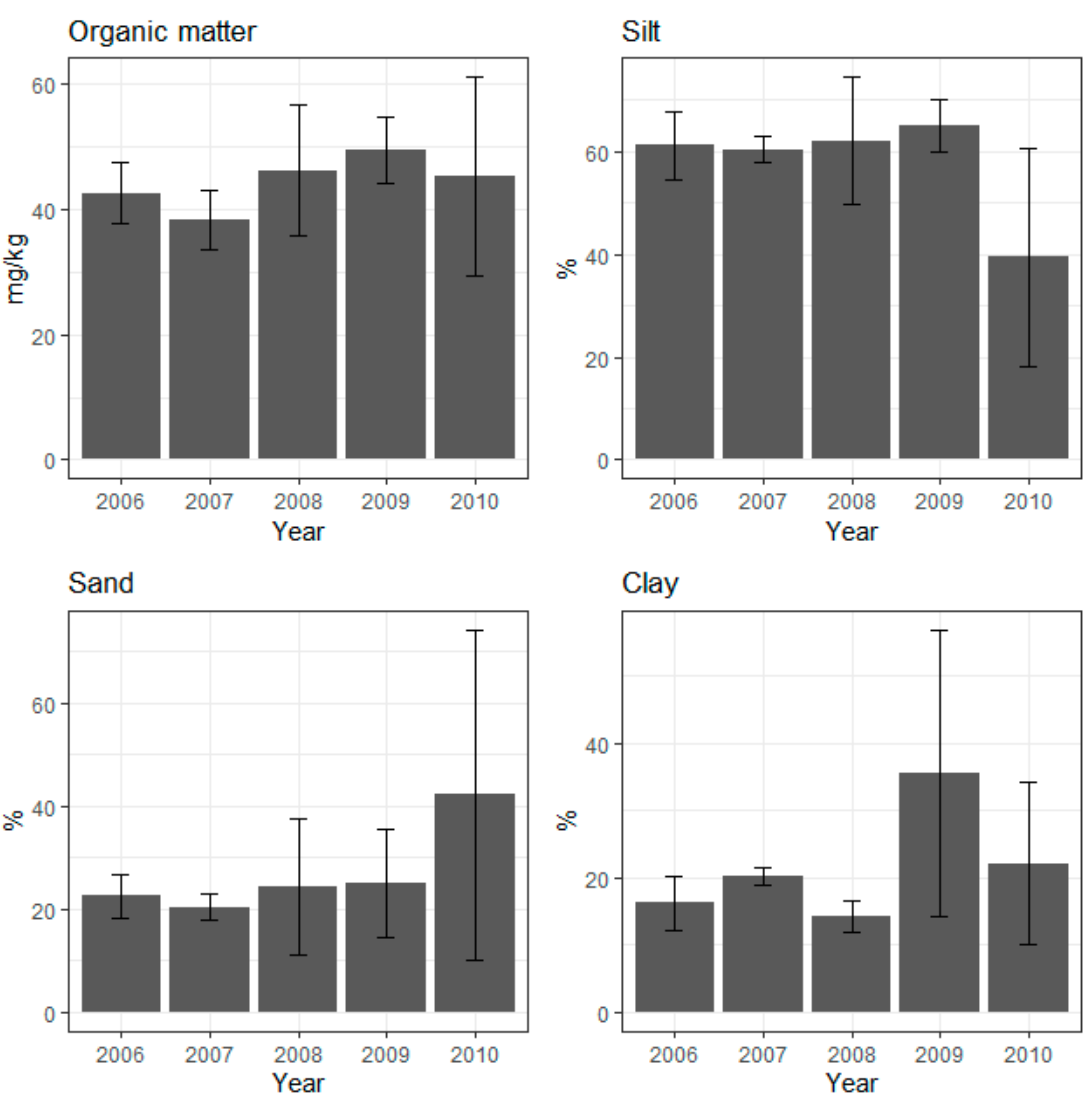
Figure 2. Sediment parameters of samples collected from 2006 to 2010 (n = 4). The average annual values (±SD) of sediment classification (sand > 50µm, silt from 50 to 2 µm, clay < 2µm). The values of organic matter are expressed in mg/kg, values of sand, silt, and clay are expressed in %.